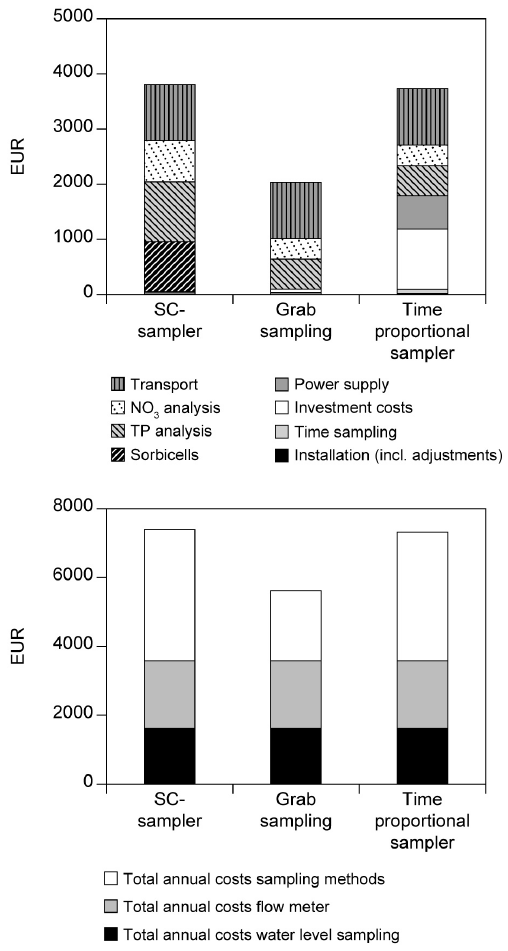
Figure 6. Comparison of costs and cost distribution per sample site and year (EUR) (top panel) and total annual costs of the sampling methods per site, including water level and flow metering (bottom